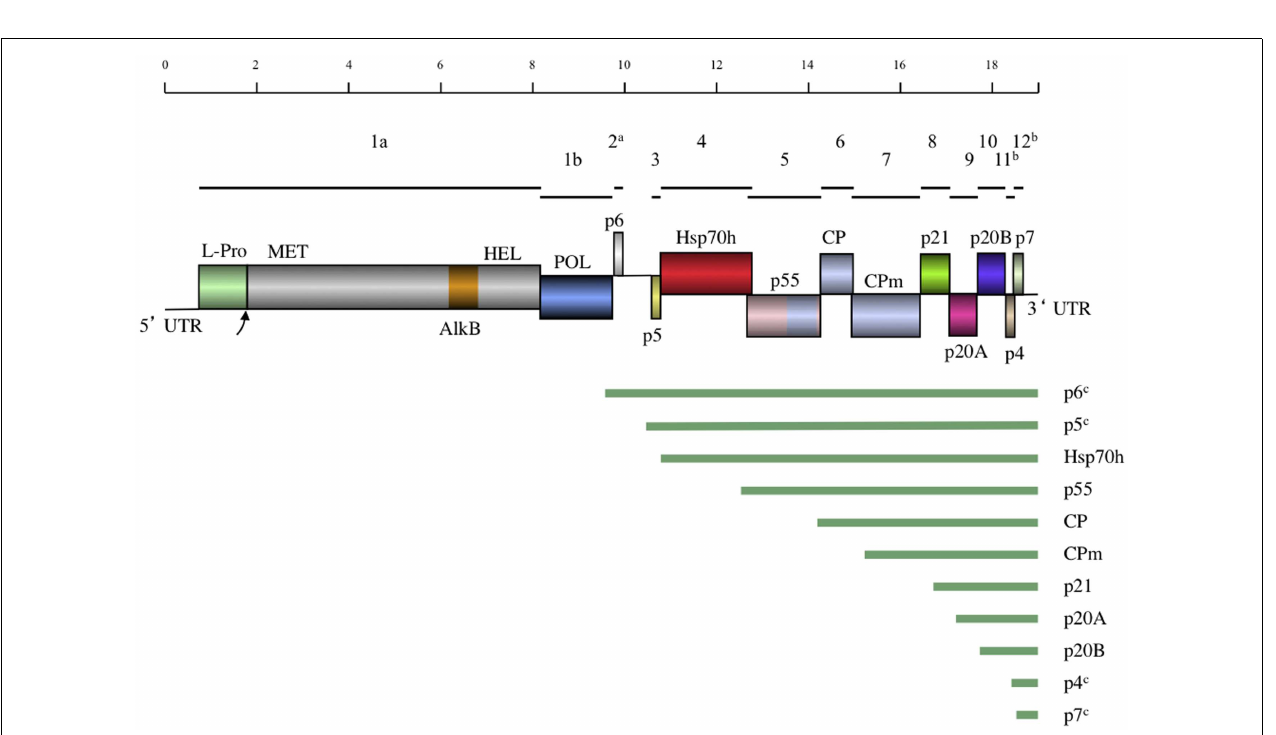
FIGURE 4 |A schematic diagram of the GLRaV-3 genome to scale. Lines above the genome map indicate the positions of the ORFs and their respective corresponding numbers. In the genome map, boxes indicate positions of genes with gene products and domains indicated. Homology between the CP and p55 and CPm is indicated by the same coloring. UTR, Untranslated region; L-Pro, Leader papain-like protease;